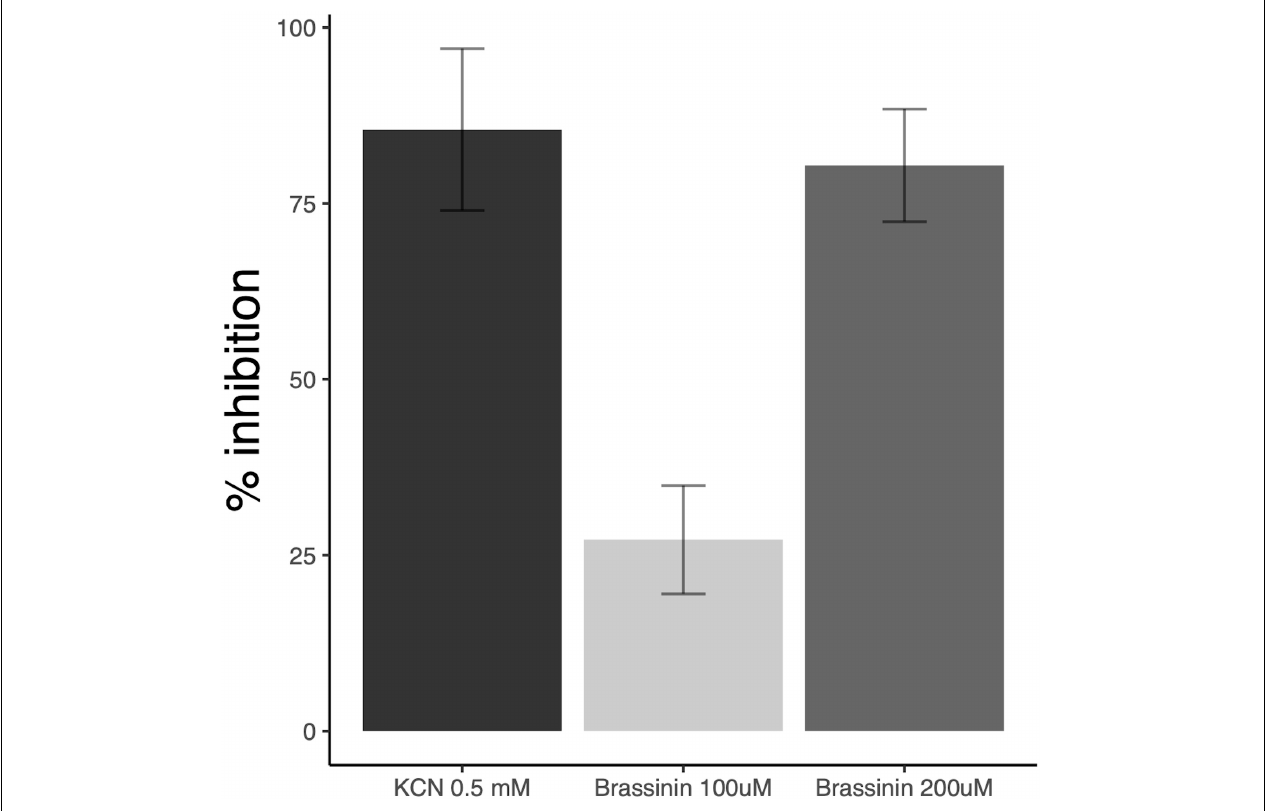
FIGURE 5 | Impact of brassinin on A. brassicicola respiration. The results are expressed as the inhibitory effects (% of the control) on the respiration rate of germlings, following 1 h-exposure to 100 and 200 µ M brassinin or 0.5 mM KCN. SD is indicated.